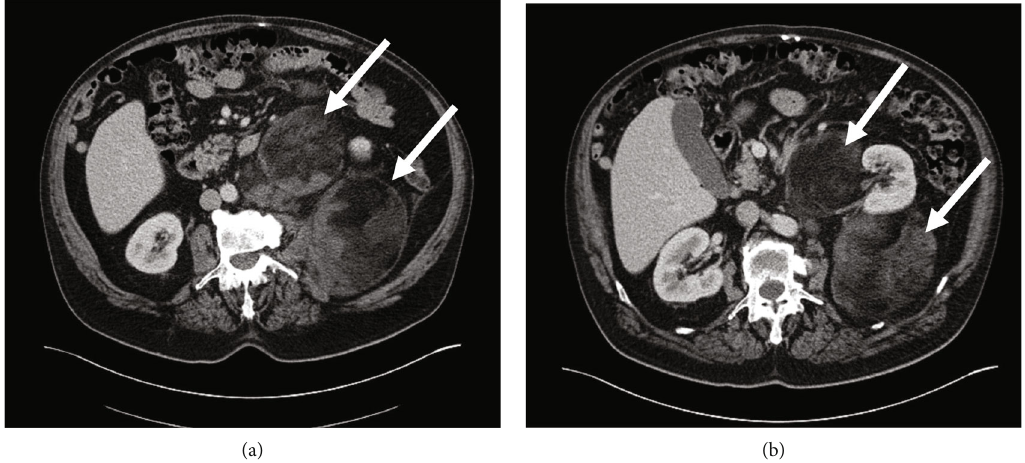
Figure 1: CT scan with multiple retroperitoneal myelolipomas (arrows).